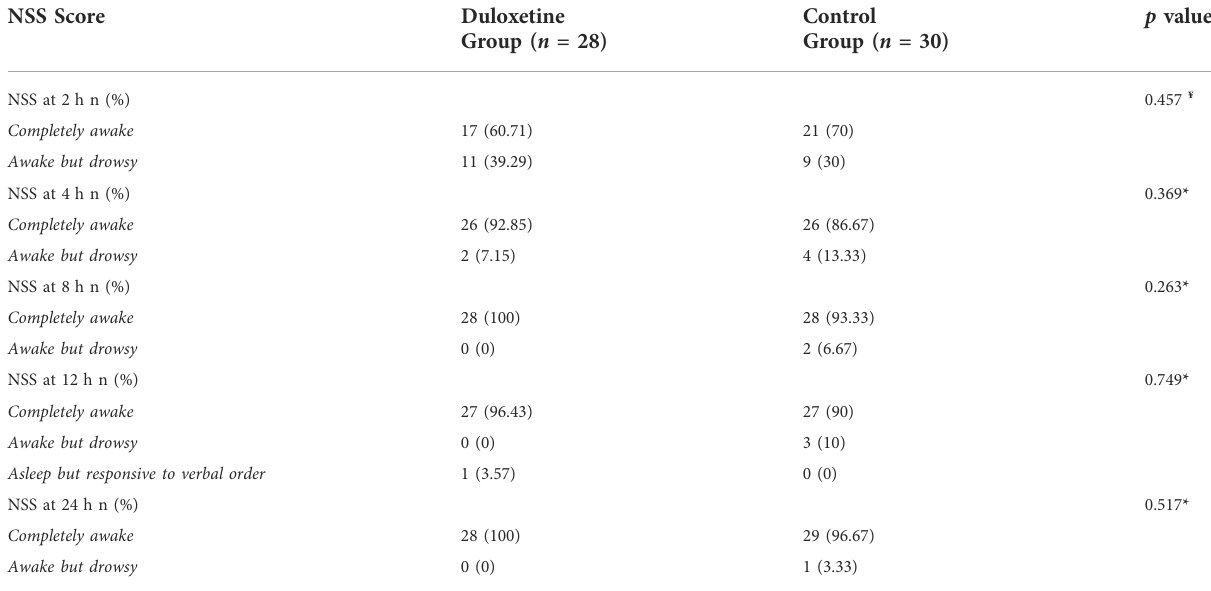
TABLE 4 The mean sedation scale score in the two groups at the different time intervals.